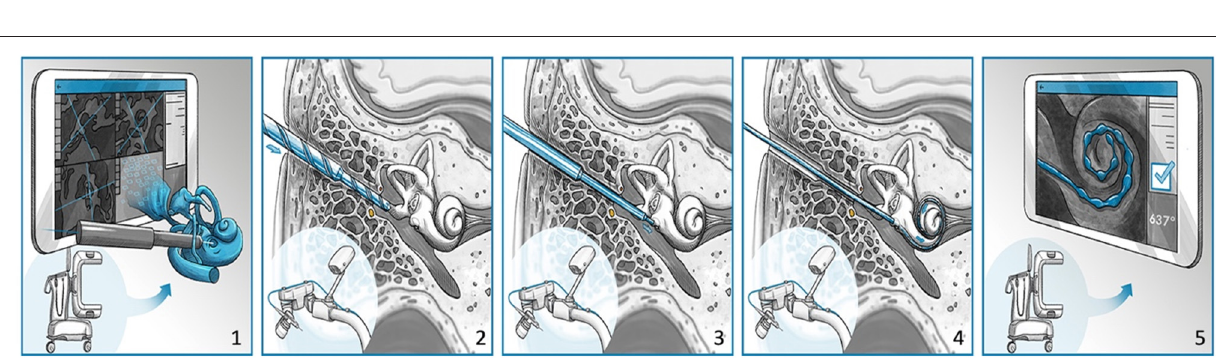
of the FN, the ChT, the ossicles, and the external auditory